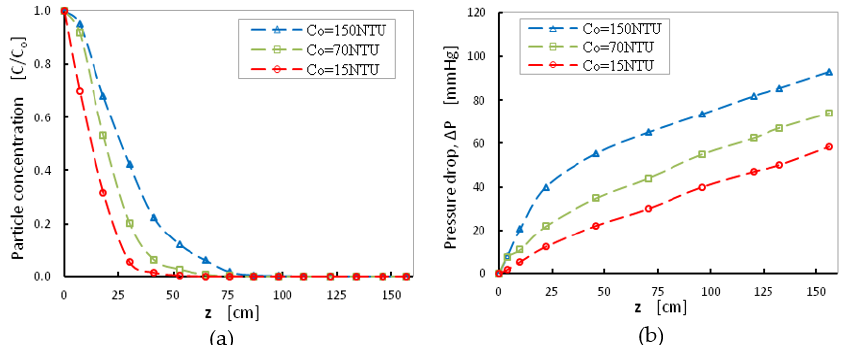
Figure 5. ( a ) Normalized particle concentration as a function of sand-bed depth and ( b ) Pressure drop as a function of sand-bed depth. Effect of turbidity value, V = 1.8 mm/s, sand grains with fine size distribution d grain < 1 mm for 8 h of filtration.